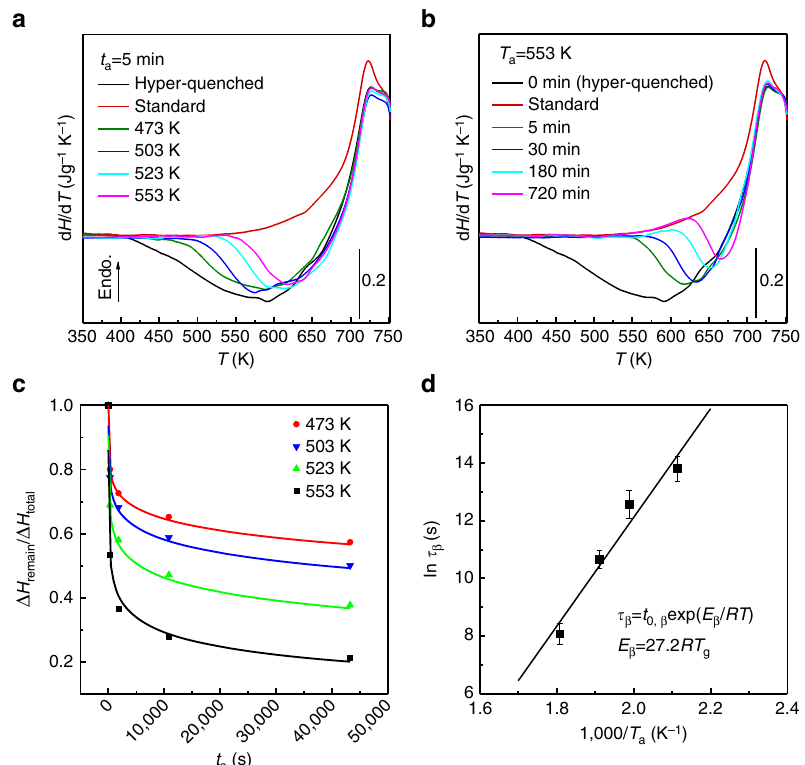
Figure 1 | Structural relaxation of hyper-quenched metallic glass below T g . ( a ) Heat flow traces of the glass samples relaxed at T a ¼ 553K for different durations; and ( b ) the samples annealed at different temperatures T a for t a ¼ 5min. ( c ) Annealing time t a dependence of the normalized remaining enthalpy for the samples annealed at 473, 503, 523 and 553K and their corresponding fittings by KWW function. ( d ) Dependence of the characteristic relaxation time t b on the reciprocal annealing temperature (1/ T a ), surrendering the activation energy of sub- T g relaxation. The error bars indicate standard deviation. Endo.,